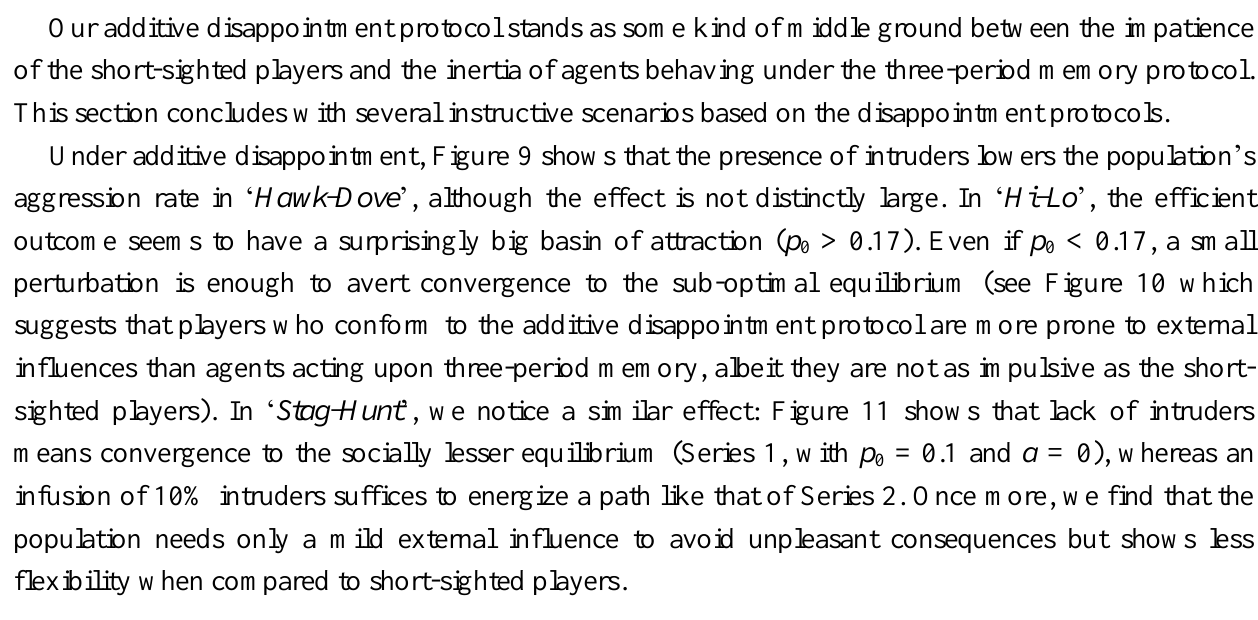
Figure 9. ‘Hawk-Dove’ with p